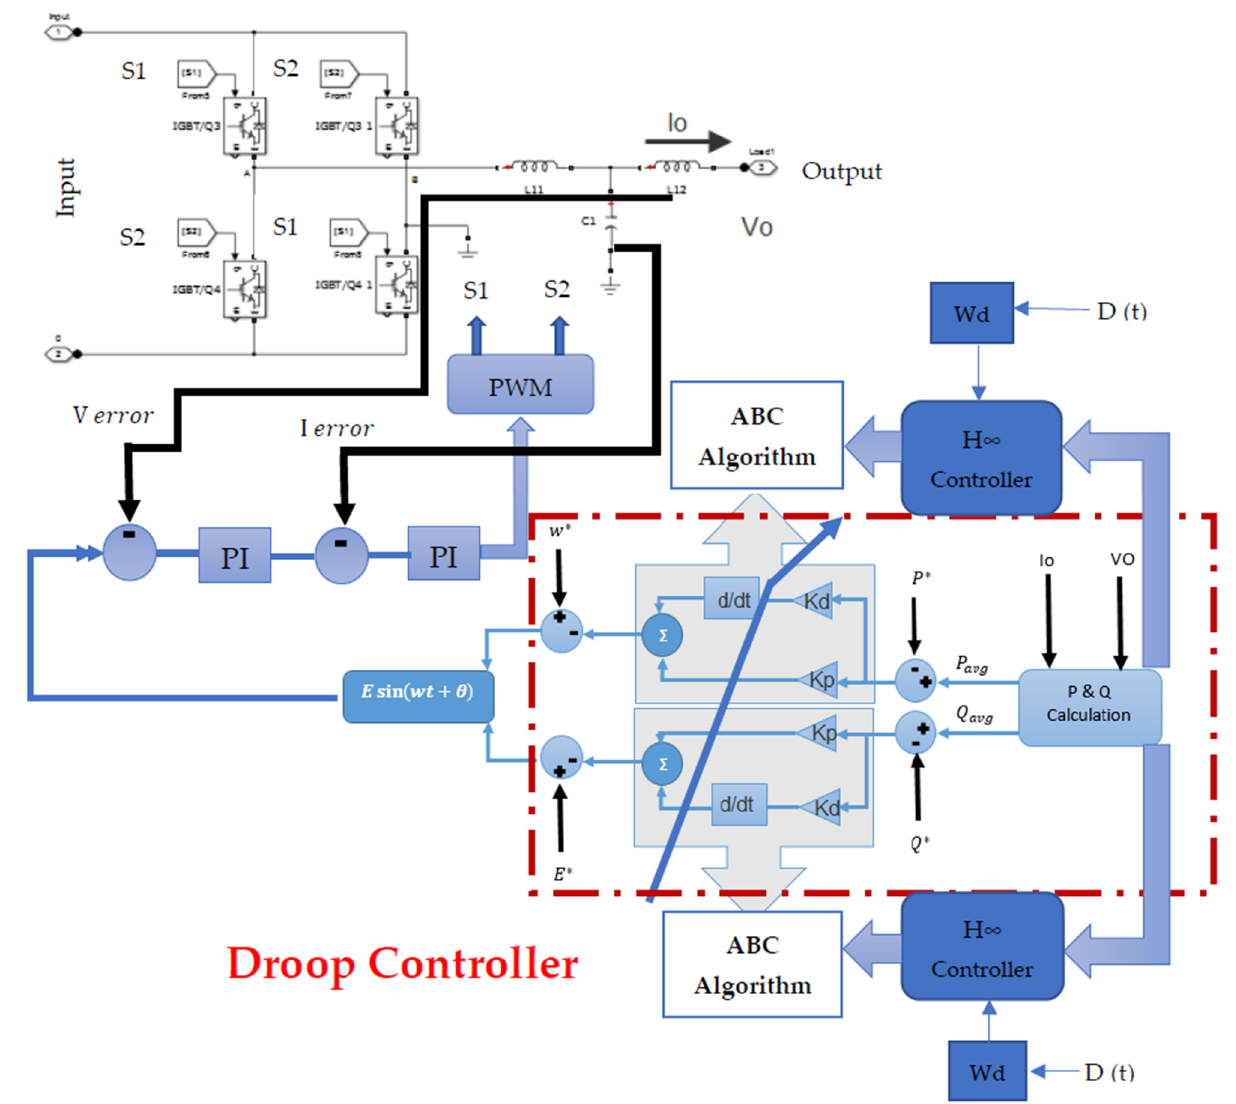
Figure 9. Scheme of the parallel inverter module by H ∞ optimal droop control with the ABC algo- rithm.